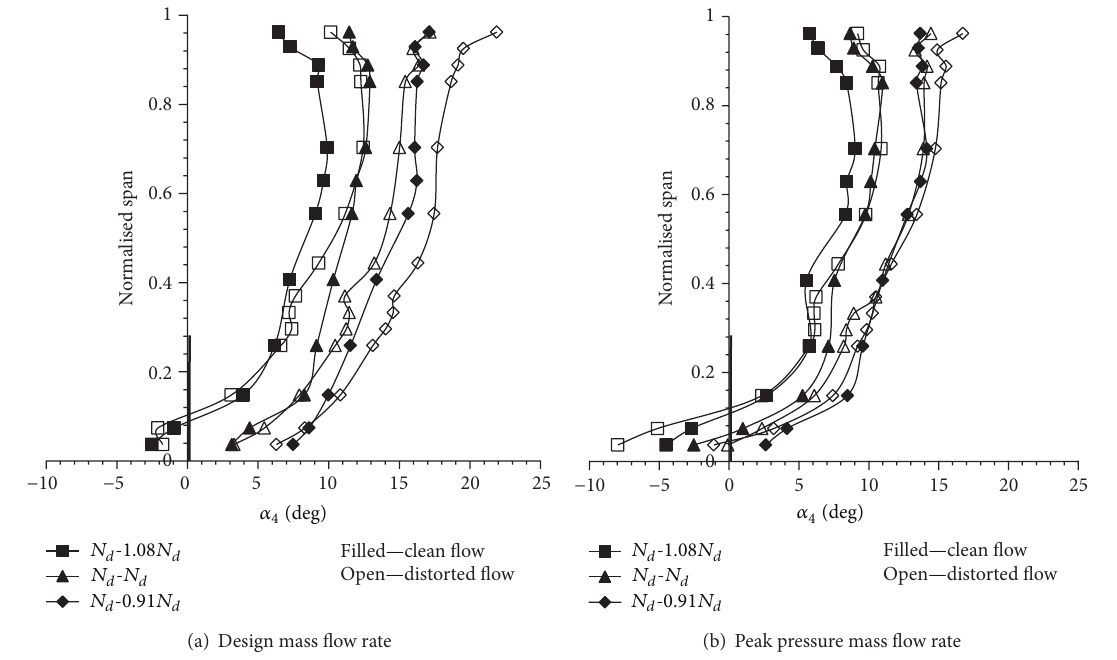
Figure 8: Spanwise variation of flow angle at the exit of rotor-2.